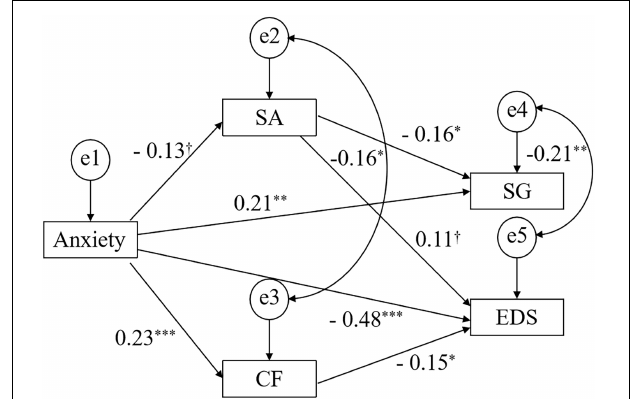
FIGURE 2 | Significant and insignificant paths from state anxiety to SG and EDS (using bias-corrected bootstrapped CIs). Mean path coefficients were obtained using 2,000 bootstrap samples. † p < 0.10, ∗ p < 0.05, ∗∗ p < 0.01, ∗∗∗ p < 0.001. Anxiety, State Anxiety; CF, Cognitive Flexibility; SA, Sustained